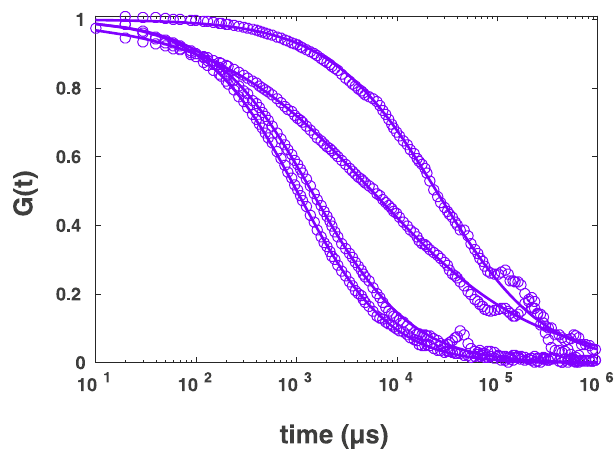
Figure 12. Experimental results of FCS measurements for diffusion of AlexaFluor647-labeled streptavidin in DMSO:glycerol solution fitted to the standard